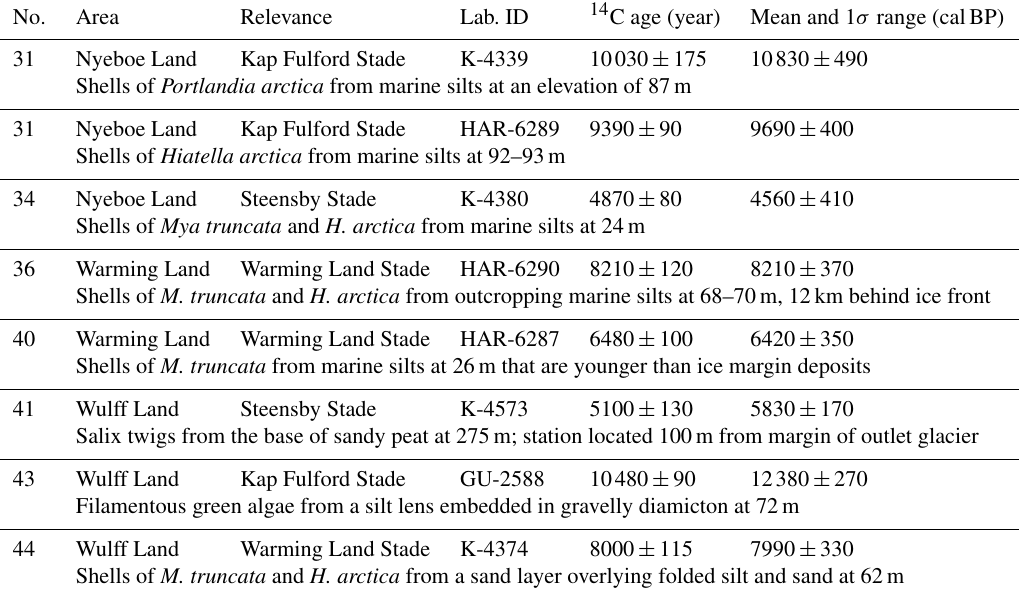
Table 1. Key radiocarbon dates originally used to constrain the ages of glacial stages in the vicinity of Sherard Osborn Fjord. Index numbers refer to original site numbers given in Kelly and Bennike (1992) with locations shown in Fig. 2. Details of the sampling sites are from Kelly and Bennike (1985) and Bennike and Kelly (1987). Ages were re-calibrated with IntCal 20 ( 41, 43 ) or Marine20 using a (cid:49)R 300 ± 300, which is consistent with the new calibrated radiocarbon dates presented in this article. Calibrated ages are rounded to 10 years. No. Area Relevance Lab.